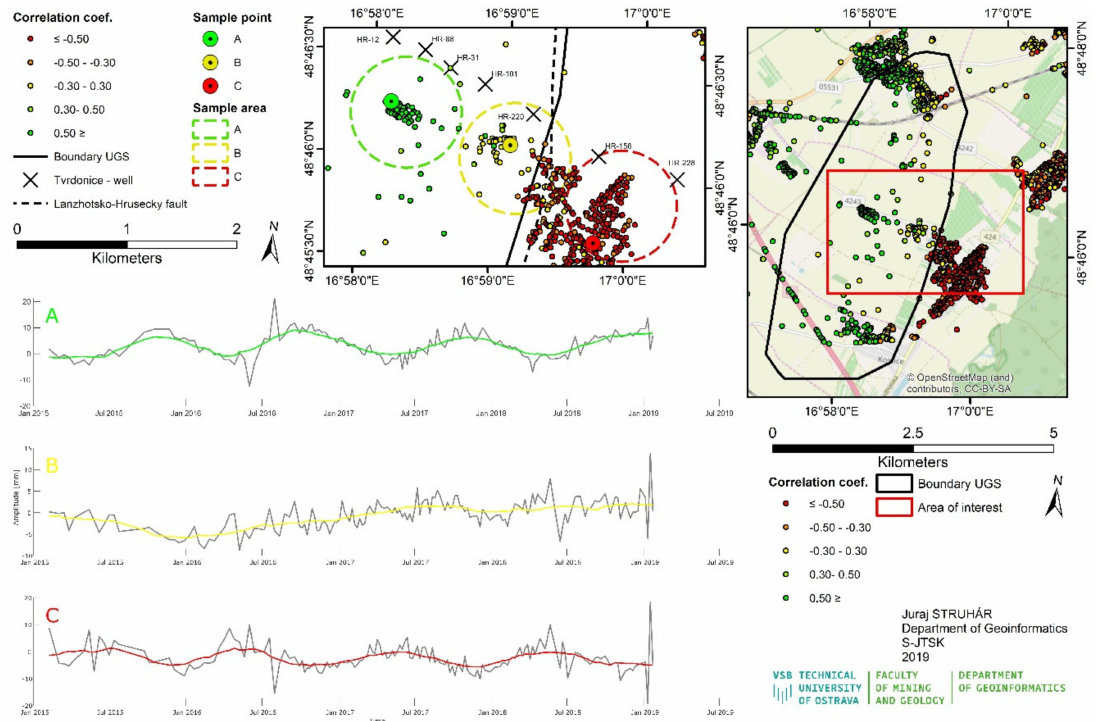
Figure 2. Example of height change time series of three PS points selected from areas A, B and C (see also Figure 8). Coarse curves represent raw data collected at these points; smooth curves are smoothed by moving average with 180-day